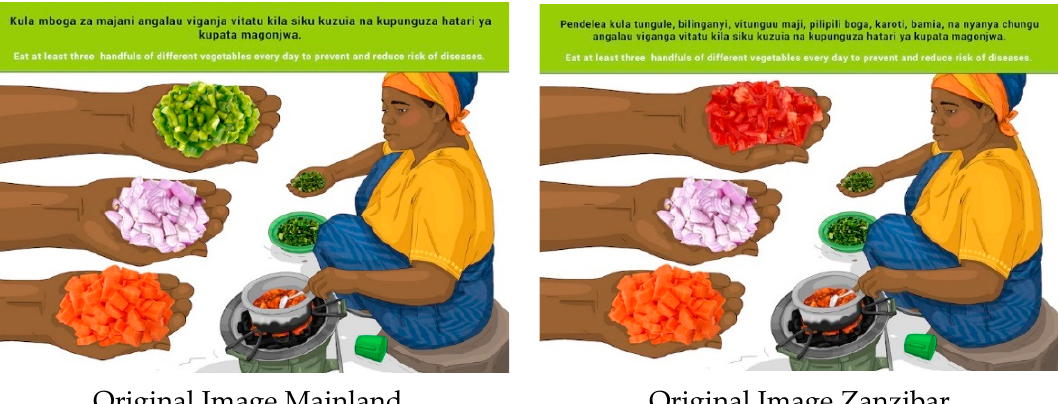
Figure 5. Eat different vegetables, at least three handfuls every day to prevent and reduce risk of diseases.